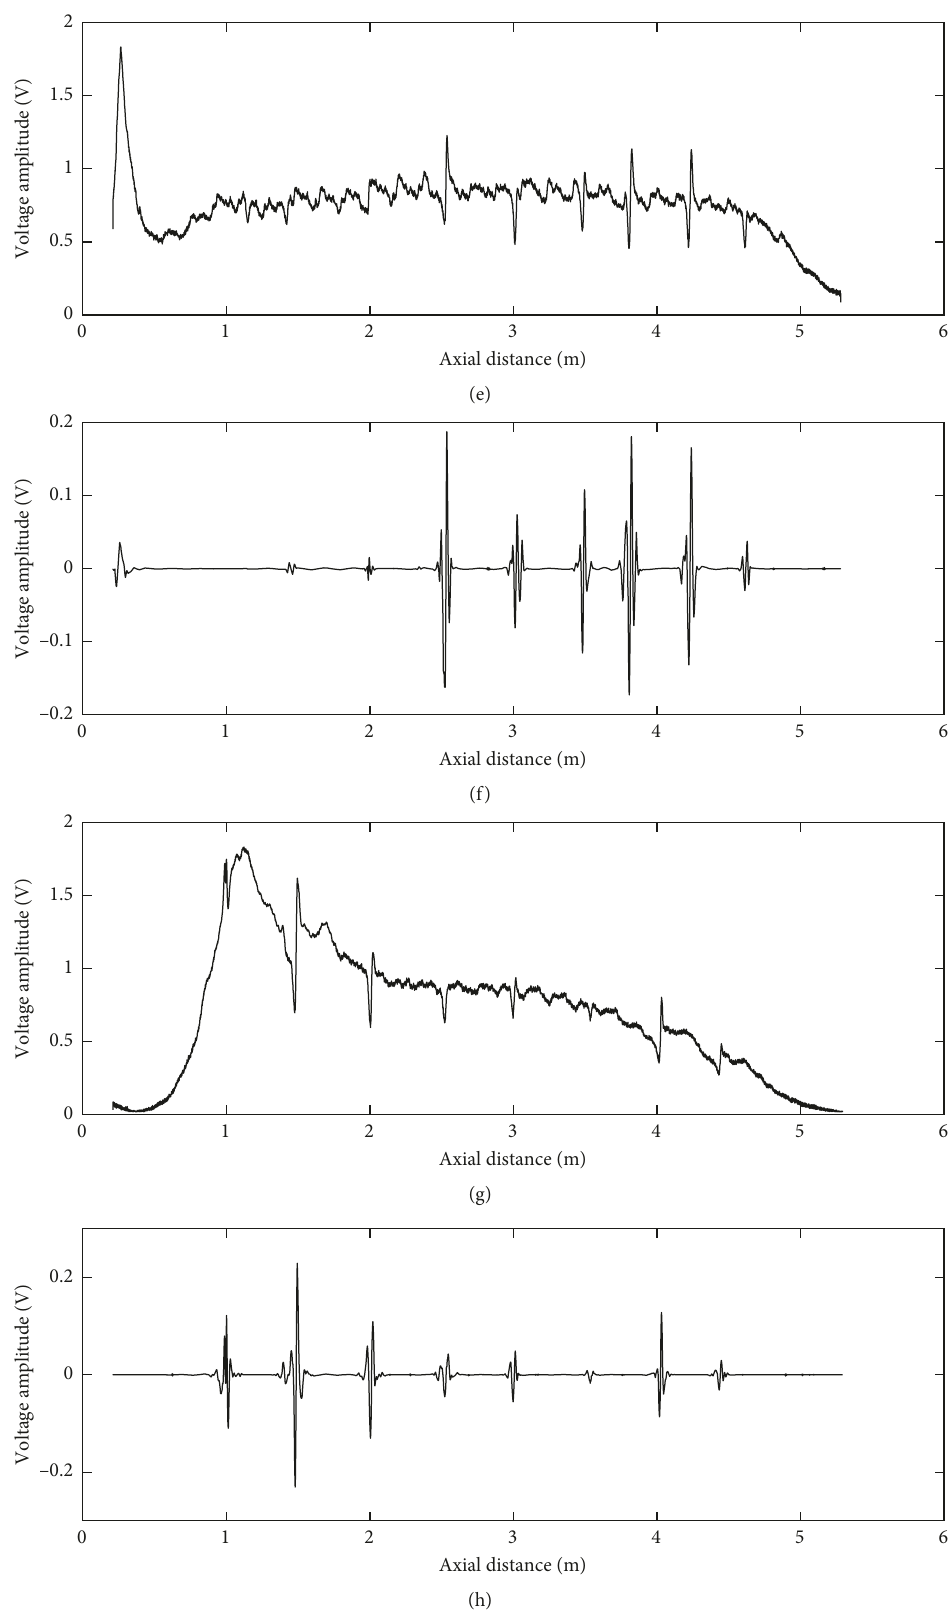
Figure 6: Single channel data before and after denoising. (a, c, e, and g): Single channel raw data. (b, d, f, and h): Single channel data after